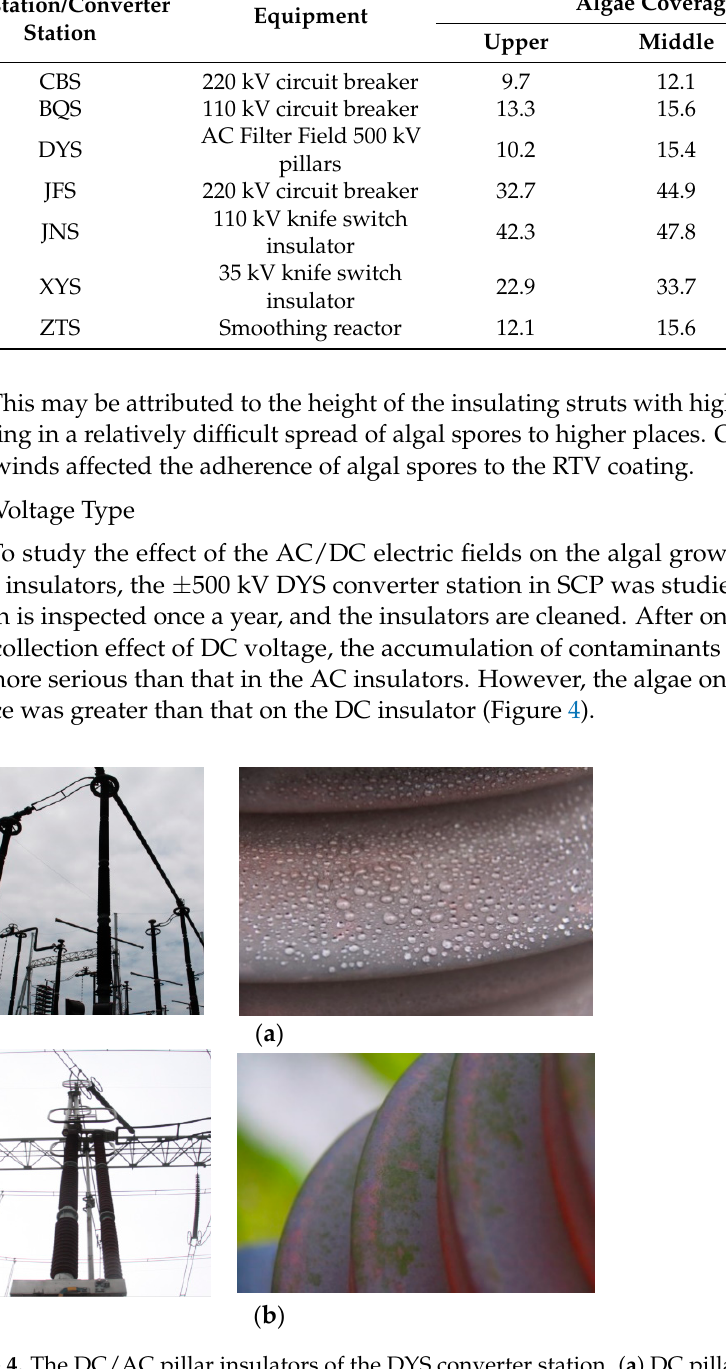
Table 3. The degree of algal growth on different parts of the insulator.